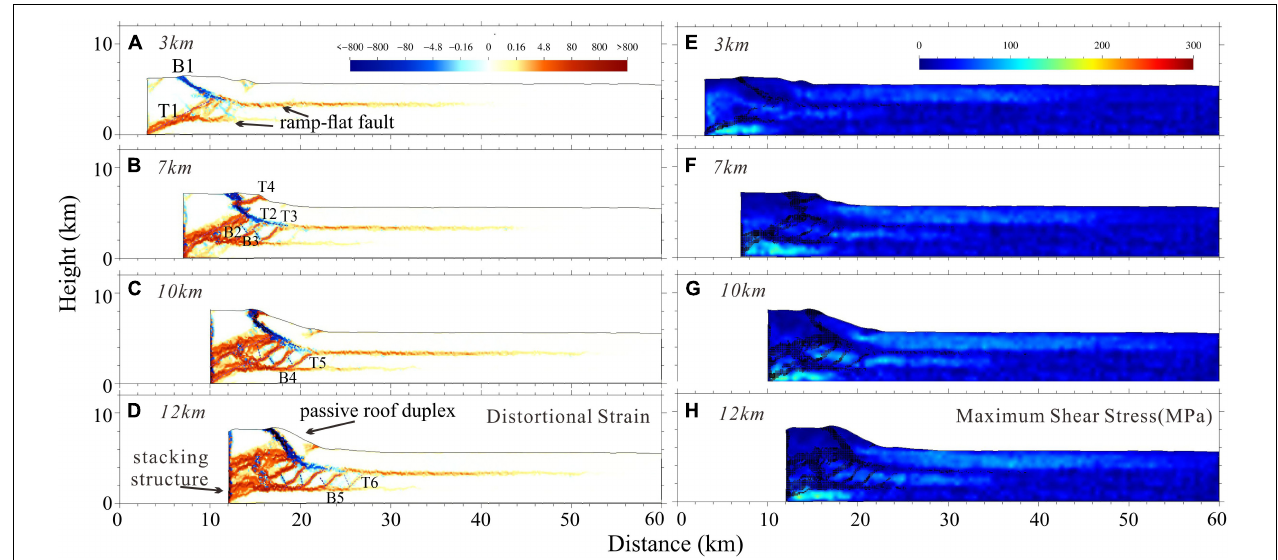
FIGURE 7 | Final distortional strain field (left) and final maximum shear stress field (right) for the simulation with two detachments and erosions at shortenings of (A,E) 3 km, (B,F) 7 km, (C,G) 10 km, and (D,H) 12 km. The shear strain magnitude is shown by color intensity; red indicates the top-to-the-right sense of shear; blue indicates the top-to-the-left sense of shear. Stress intensity scales with color. T1–T6 and B1–B5 denote fore-thrusts and back-thrusts, respectively, in the order of their